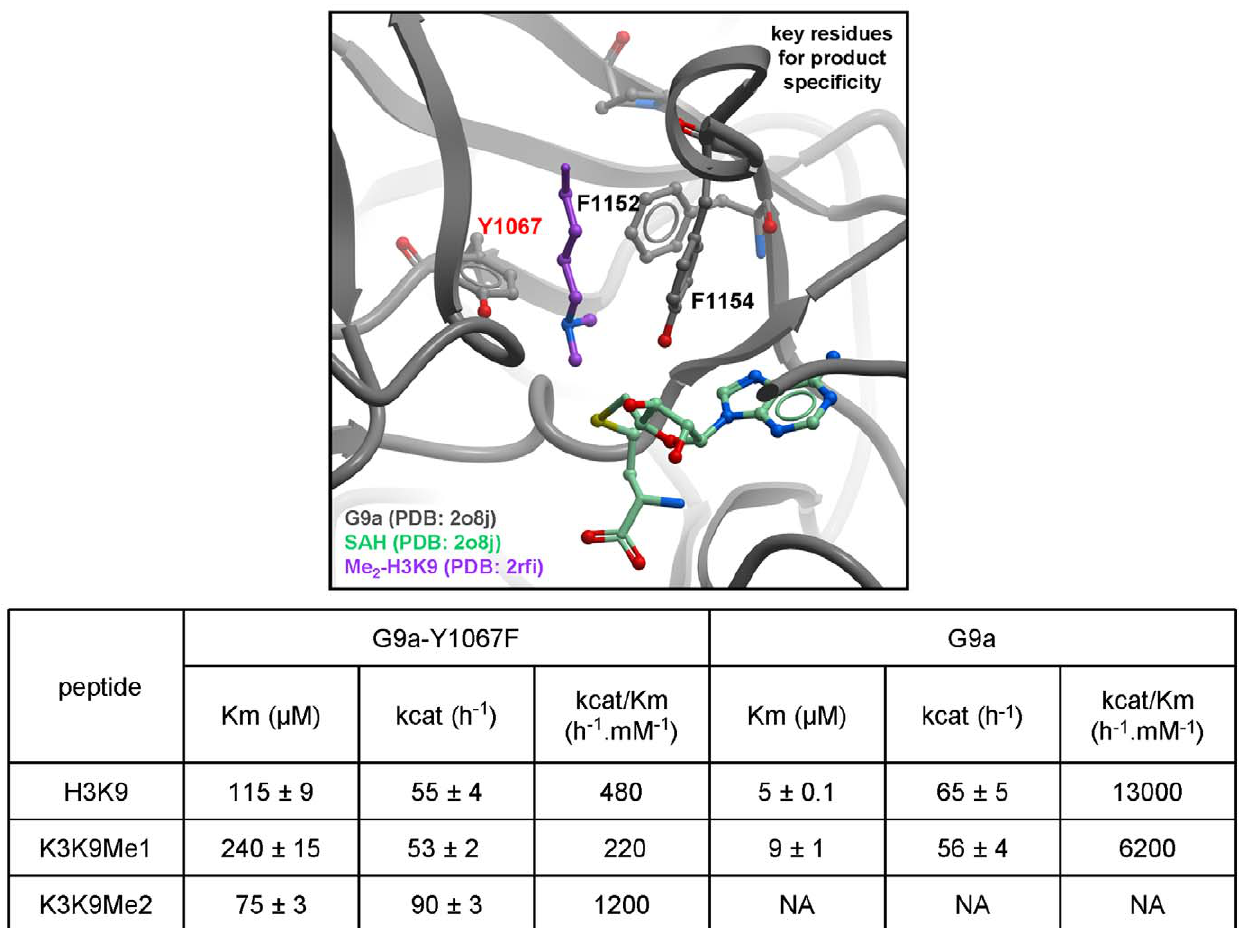
Figure 3. Structural determinants of G9a mono/di-methylation specificity. A model of substrate lysine-bound G9a (Top panel) was generated from the superposition of the active sites of the GPL ternary complex and GLP. Y1067 of G9a stabilizes the di-methylamine end of the substrate lysine in an orientation where the lone-pair is not facing the co-factor, thereby disfavoring transfer of a third methyl group. The Y1067F mutant loses this restriction and can tri-methylate its substrate, as indicated in the table. Previous work had shown that the F1152Y G9a mutant can only mono-methylate H3K9 [29].